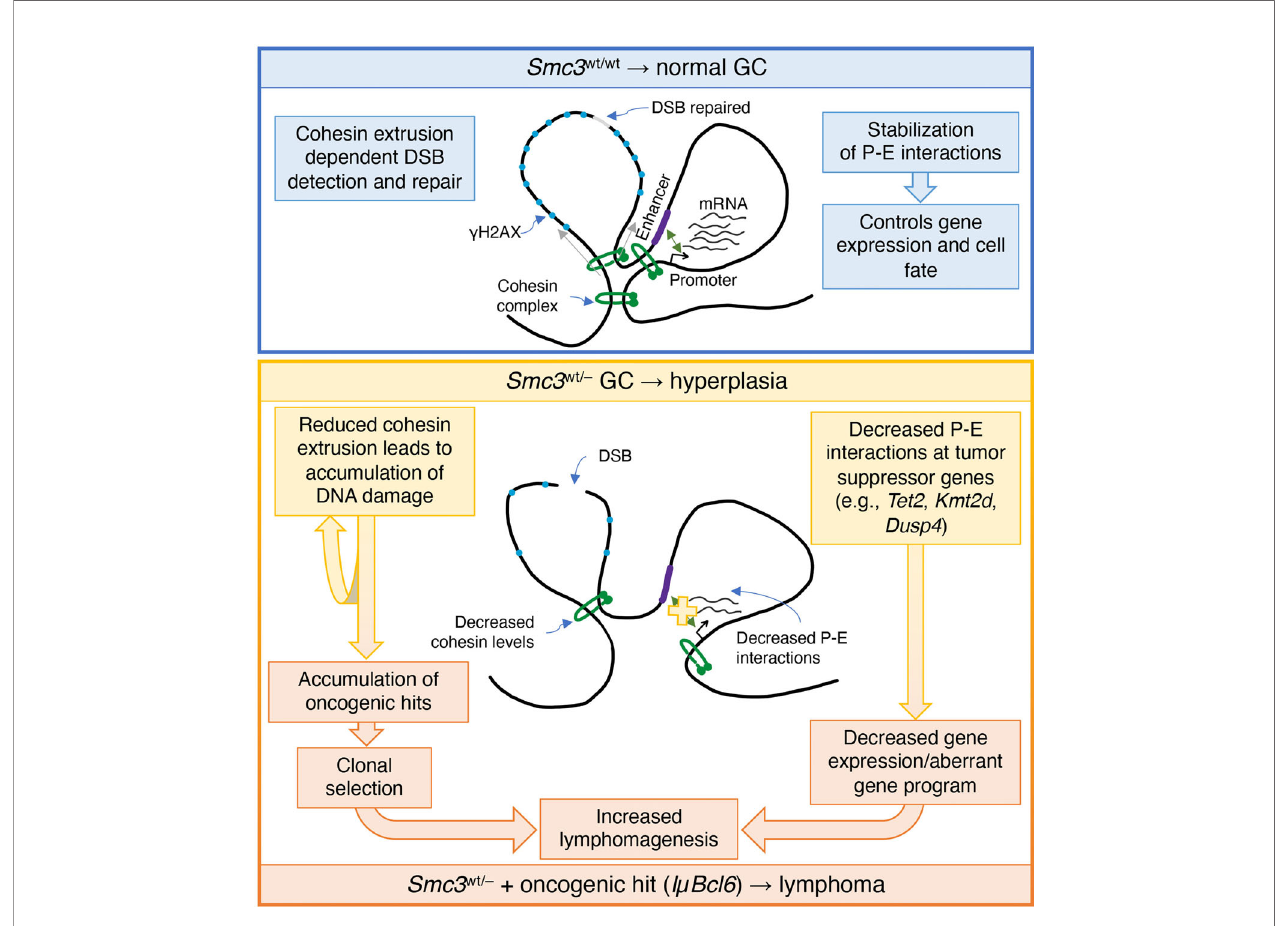
FIGURE 7 | Model of cohesin haploinsuf fi ciency induced lymphomagenesis. Biallelic dosage of the Smc3 cohesin subunit enables promoter-enhancer (P-E) interactions of critical genes for cell identity and cell fate. In addition, the extrusion function of cohesin plays an important role in detection of double strand breaks (DSB) and establishment of phosphorylated histone H2AX ( g H2AX). In Smc3 haploinsuf fi cient GCs, decreased promoter-enhancer interactions in tumor suppressor genes such as Tet2 , Kmt2d and Dusp4 , result in decreased gene expression and/or alteration of the gene program. Defective detection of DSB leadsto accumulation of chromosomal aberrationsthat are mechanisticallylinked to reducedabundance of Smc3 proteinand hence fewer cohesin loop extrusion complexes, both of which may play a